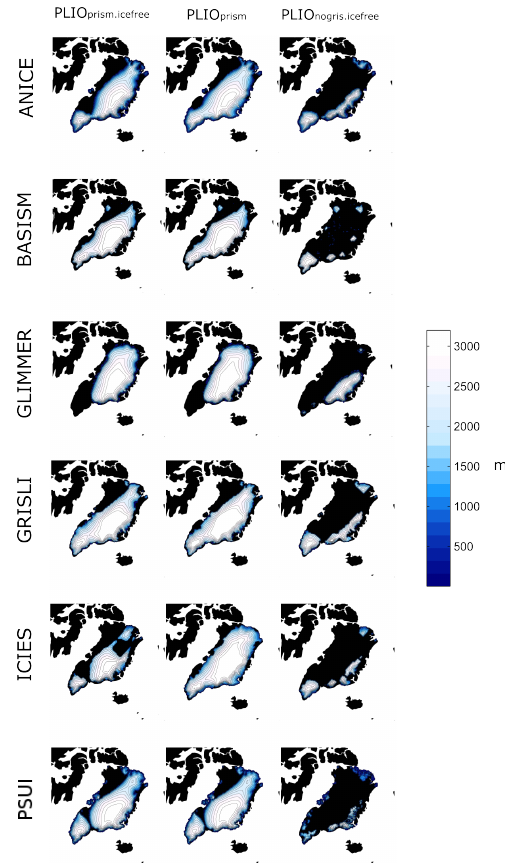
Figure 4. Ice sheet surface elevation [m] for Pliocene scenar- ios Plio prism . icefree (left panels), Plio prism (middle panels), and Plio nogris . icefree (right panels) for individual ice sheet models AN- ICE, BASISM, Glimmer, GRISLI, IcIES, and PSUI (from top to